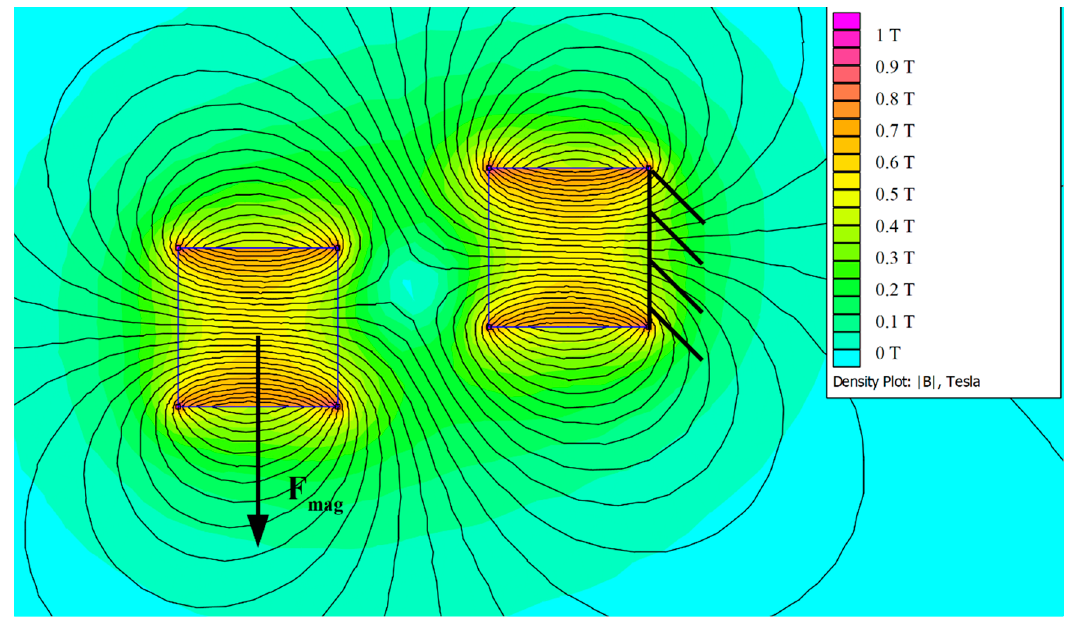
Figure 8. Magnetic Field Simulation of Auxiliary Magnets in Software FEMM 4.2.